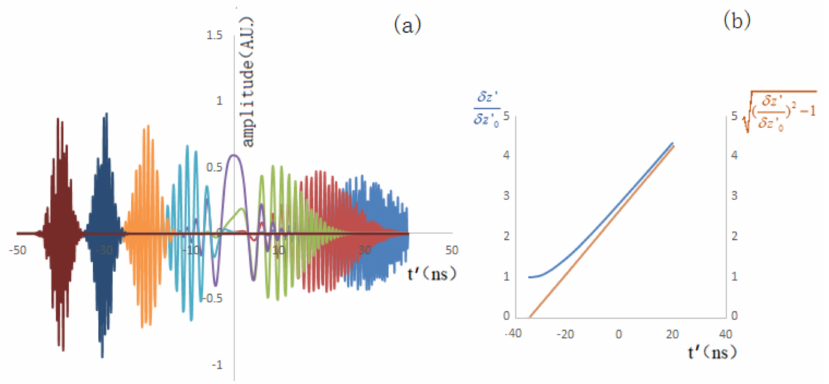
Figure 3. The simulation result using the parameter of 10 km SMF. ( a ) The signal at different t (cid:48) , colors from left to right are used for signals at t (cid:48) = − 40, − 30, − 20, − 10, 0, 10, 20, 30 ns, respectively; ( b ) the relationship between the resolution expansion and t (cid:48)